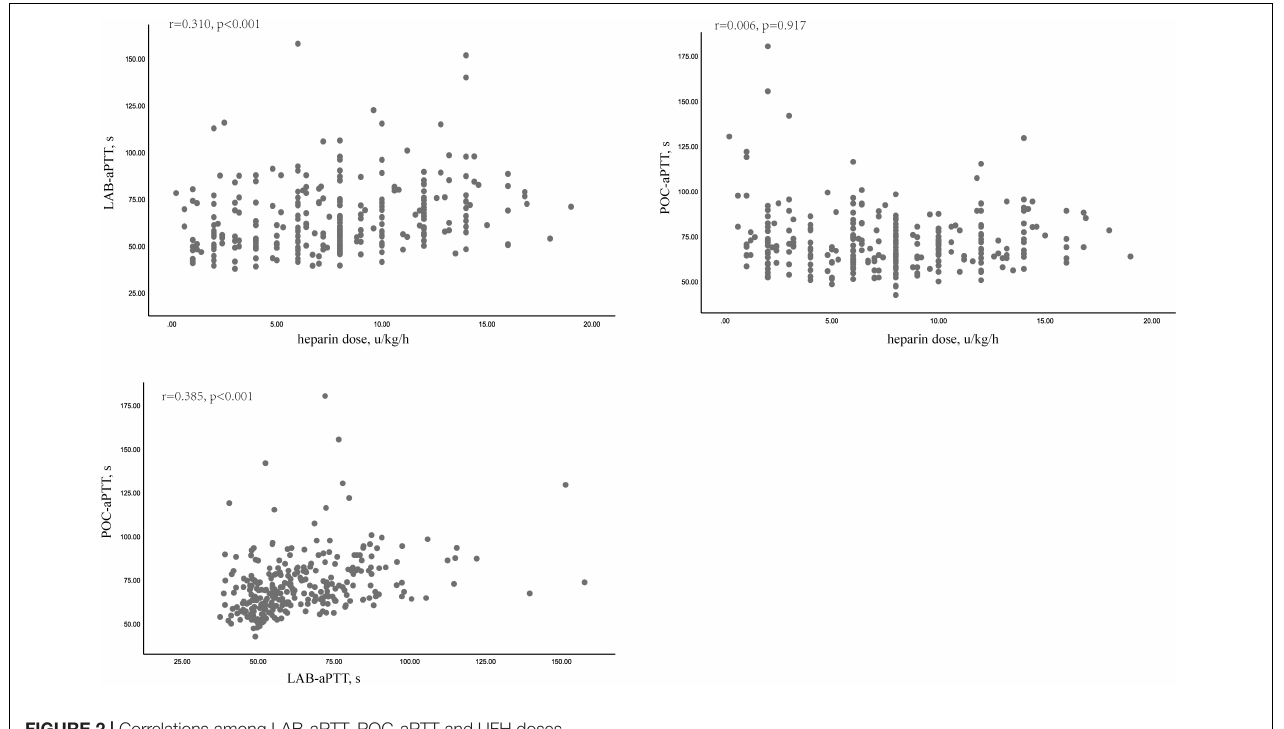
FIGURE 2 | Correlations among LAB-aPTT, POC-aPTT and UFH doses.